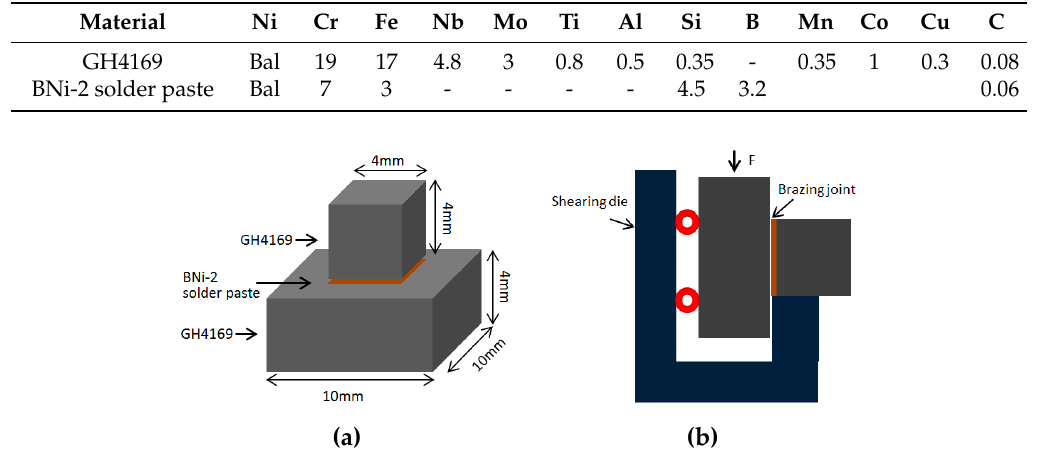
Table 1. Chemical composition (wt.%) of the base metals and solder paste.